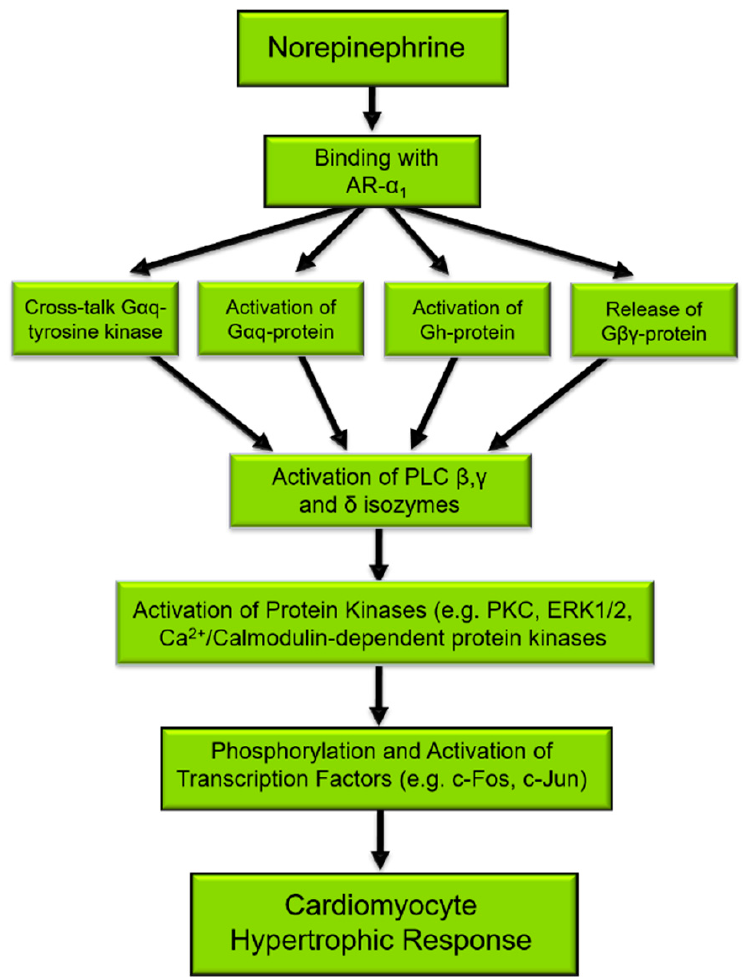
Figure 1. Norepinephrine-induced signal transduction resulting in cardiomyocyte hypertrophy. α 1 -AR, α 1 -adrenoceptors; G α q, G q protein alpha subunit; PLC, phospholipase C. There are several pro- teins that are phosphorylated such as ERK1/2, PKC, Ca 2+ /Calmodulin-dependent kinase, and JNK [32], which in turn phosphorylate and activate transcription factors such as c-Fos and c-Jun leading to the gene expression of PLC as well as the expression of fetal genes that are characteristic of cardiac hypertrophy [9,33].